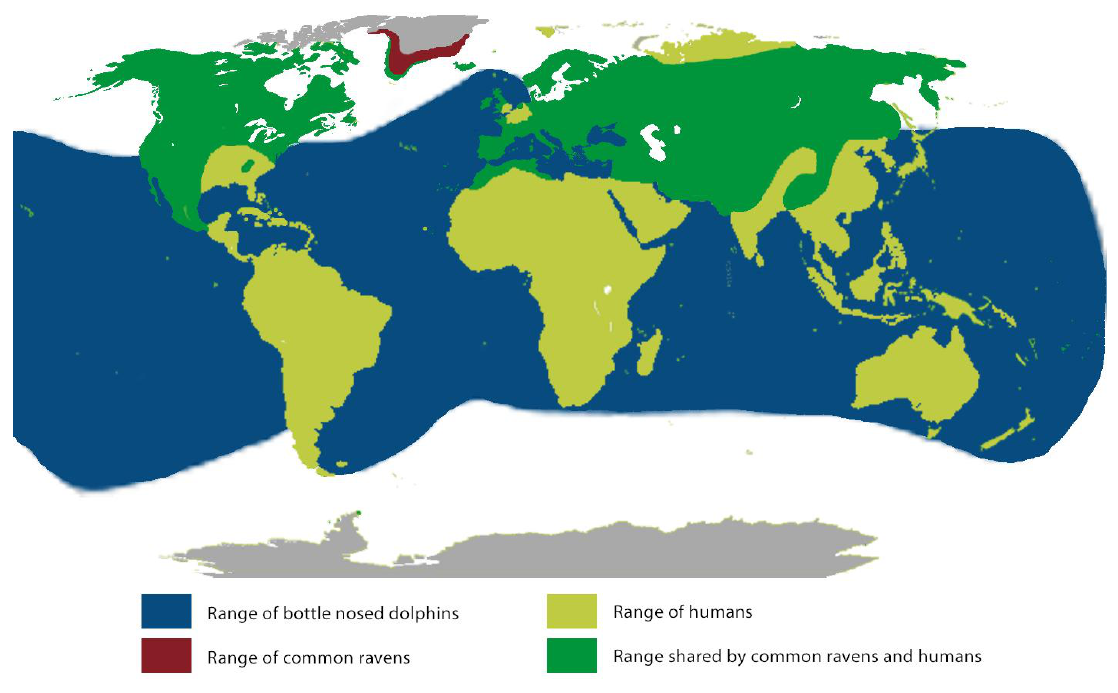
Figure 2. The ranges inhabited by humans, bottlenose dolphins and common ravens. Humans do not have as close of relatives as the common raven or the bottle-nosed dolphin; among the corvids and delphinids, many species have only minor morphological differences. Therefore, taken as a whole, the ranges of corvids and delphinids exceed those shown in the